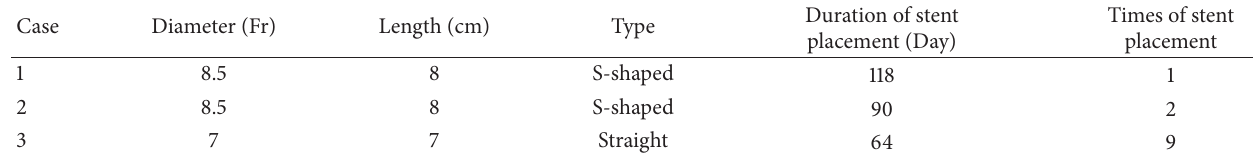
Table 7: Stents characteristics of dislocated cases.